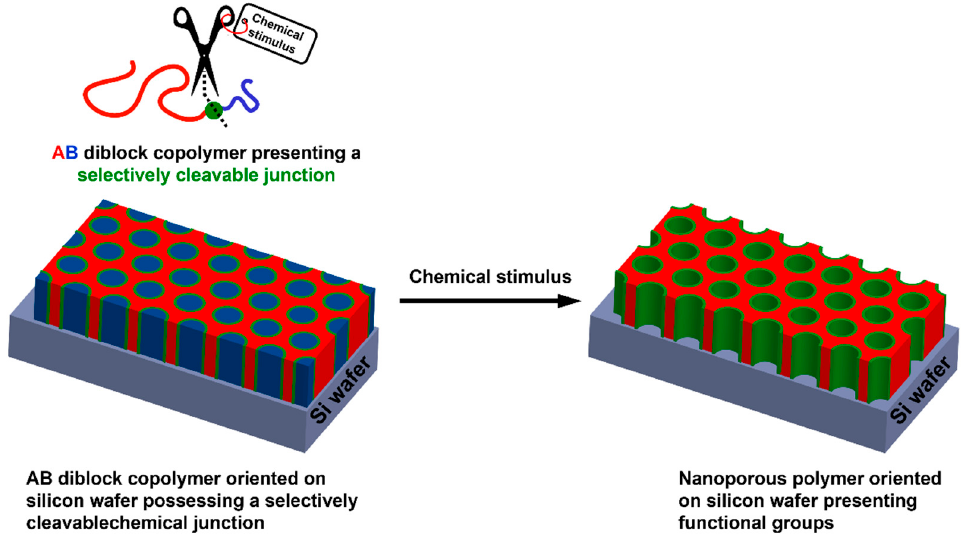
Figure 7. General procedure for the preparation of functional oriented nanoporous polymers from AB diblock copolymer-based thin films presenting a selectively cleavable junction.